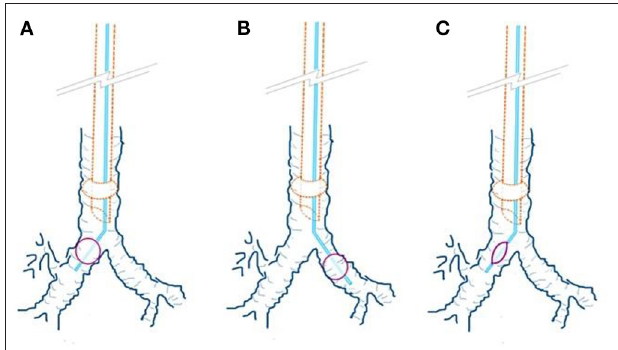
FIGURE 1 | Endobronchial blocker (EB) position and ventilation statuses. (A) The right EB cuff was inflated; this simulates left endobronchial intubation. (B) The left EB cuff was inflated; this simulates right endobronchial intubation. (C) The EB cuff was not inflated; this simulates normal tracheal